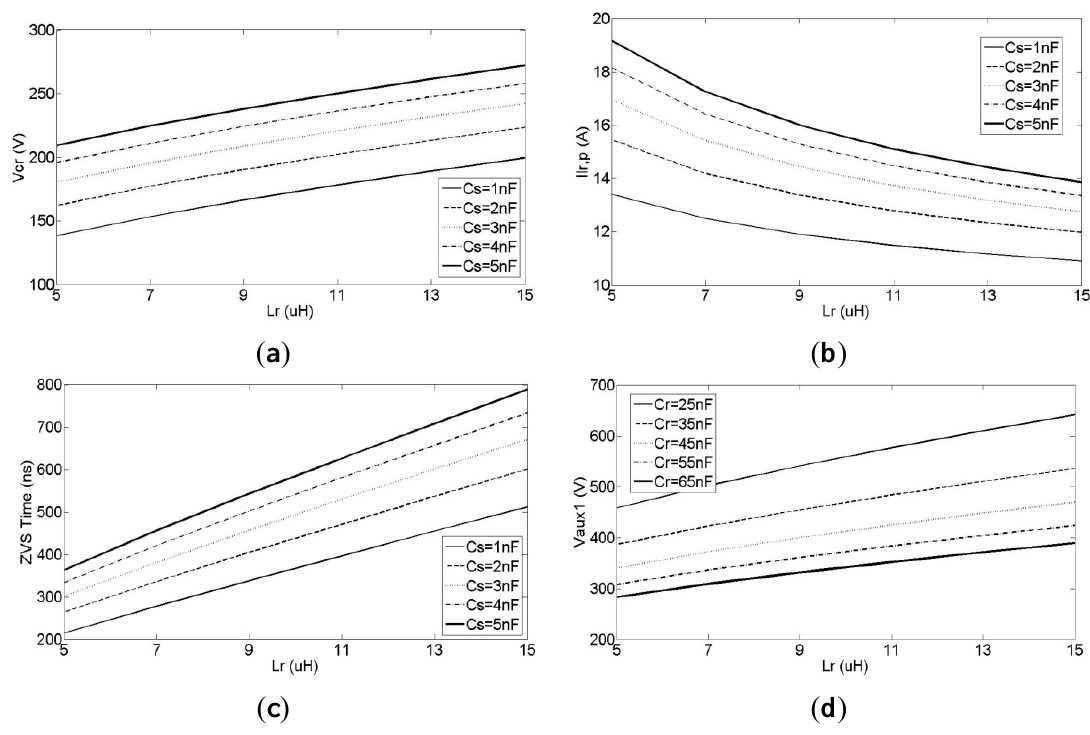
with C = 50 nF; ( b ) Graph of characteristic curves of I S r with C = 50 nF; ( c ) Graph of characteristic curves of I S r with C = 50 nF; ( d ) Graph of characteristic curves of V S r with C = 2 r S